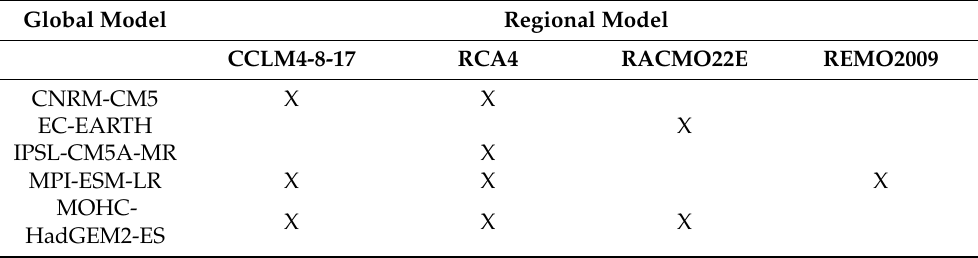
Table 1. Combinations of the Global Climate Models (GCM) and the Regional Climate Models (RCM) were used in this